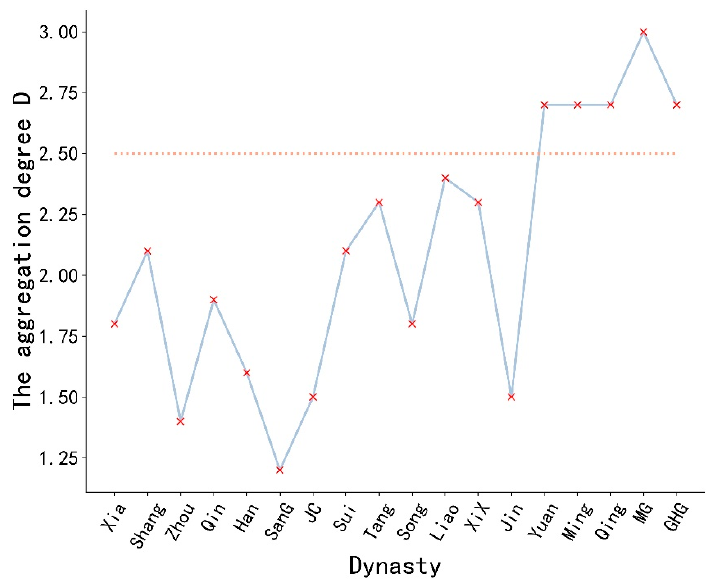
Figure 5. Aggregation degree of the spatial distribution in a dynasty.